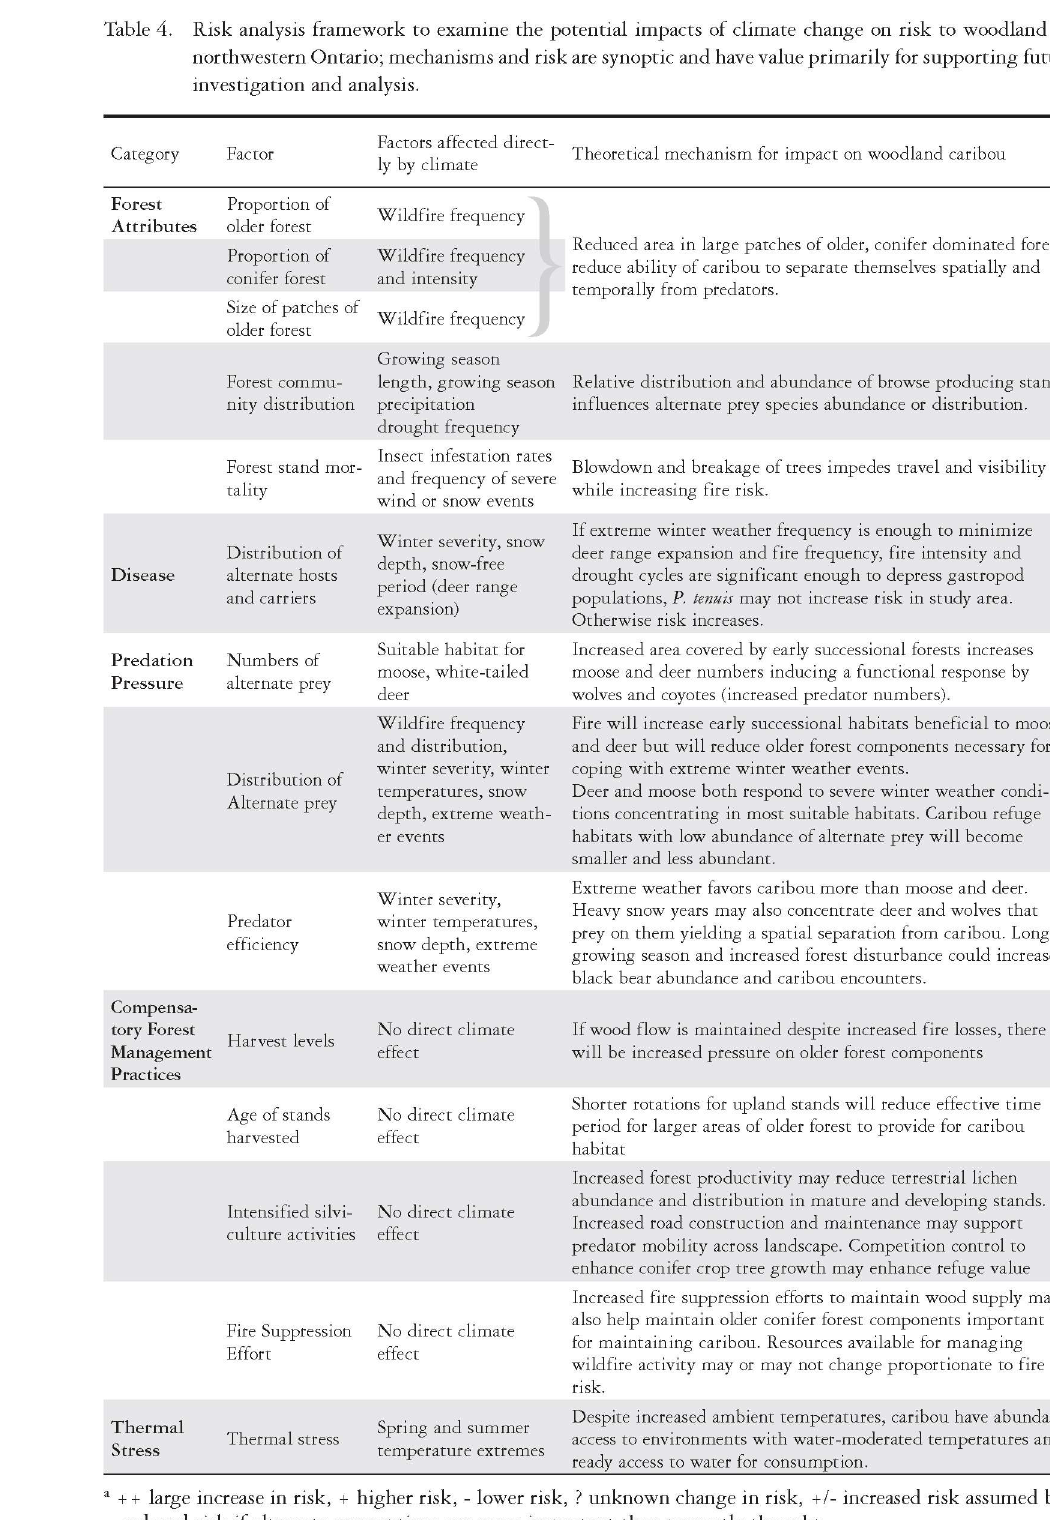
Table 4. Risk analysis framework to examine the potential impacts of climate change on risk to woodland caribou in northwestern Ontario; mechanisms and risk are synoptic and have value primarily for supporting future debate, investigation and